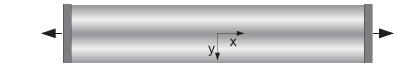
Figure 3: Load case 1 illustration (for n = 1 ).